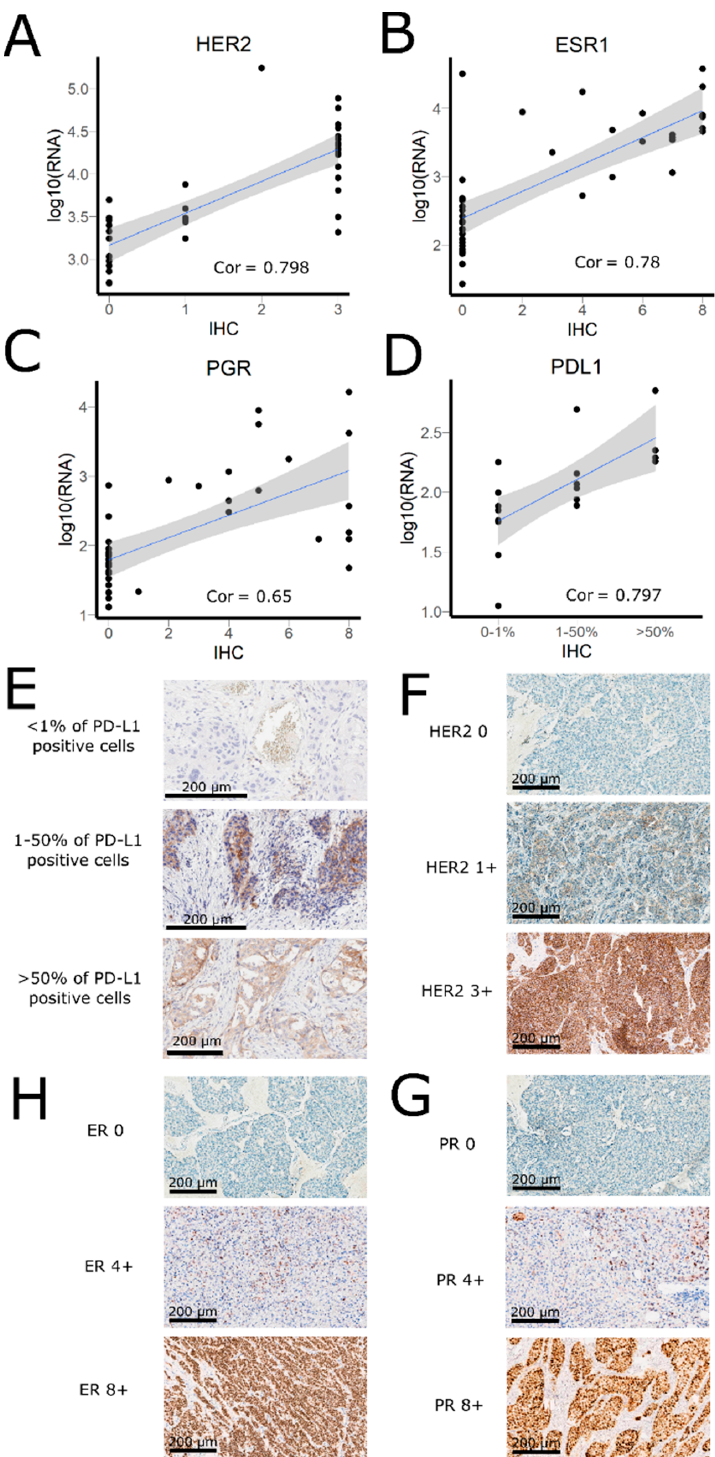
Figure 4. IHC results vs. mRNA level measured by NGS RNA sequencing: ( A ) HER2: correlation coefficient (Spearman’s rho) = 0.798 ( p -value = 6.9 × 10 − 10 ); ( B ) ESR1: correlation coefficient (Spearman’s rho) = 0.777 ( p -value = 3.8 × 10 − 9 ); ( C ) PGR: correlation coefficient (Spearman’s rho) = 0.653 ( p -value = 4.9×10 − 6 ); ( D ) PD-L1: correlation coefficient (Spearman’s rho) = 0.797 ( p -value =4.4 × 10 − 5 ). Grey zone indicates 95% confidence interval for the trendlines; ( E ) PD-L1 IHC staining examples. ( F ) HER2 IHC staining examples; ( H ) ER (ESR) IHC staining examples; ( H ) PR (PGR) IHC staining examples. Cor—correlation coe ffi